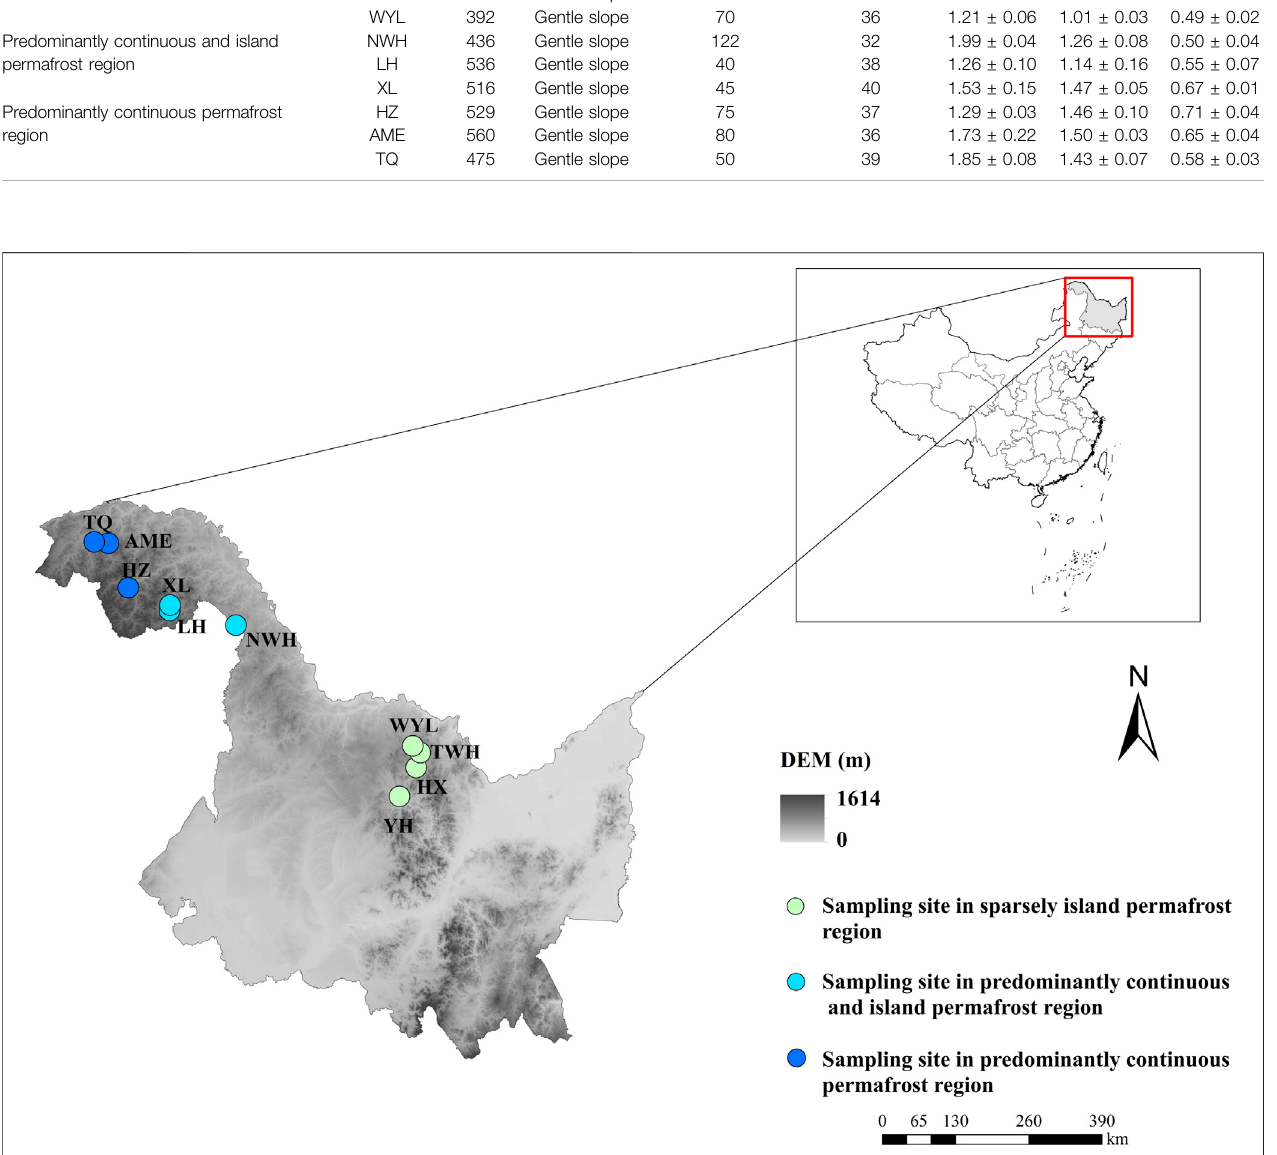
Frontiers in Environmental Science |